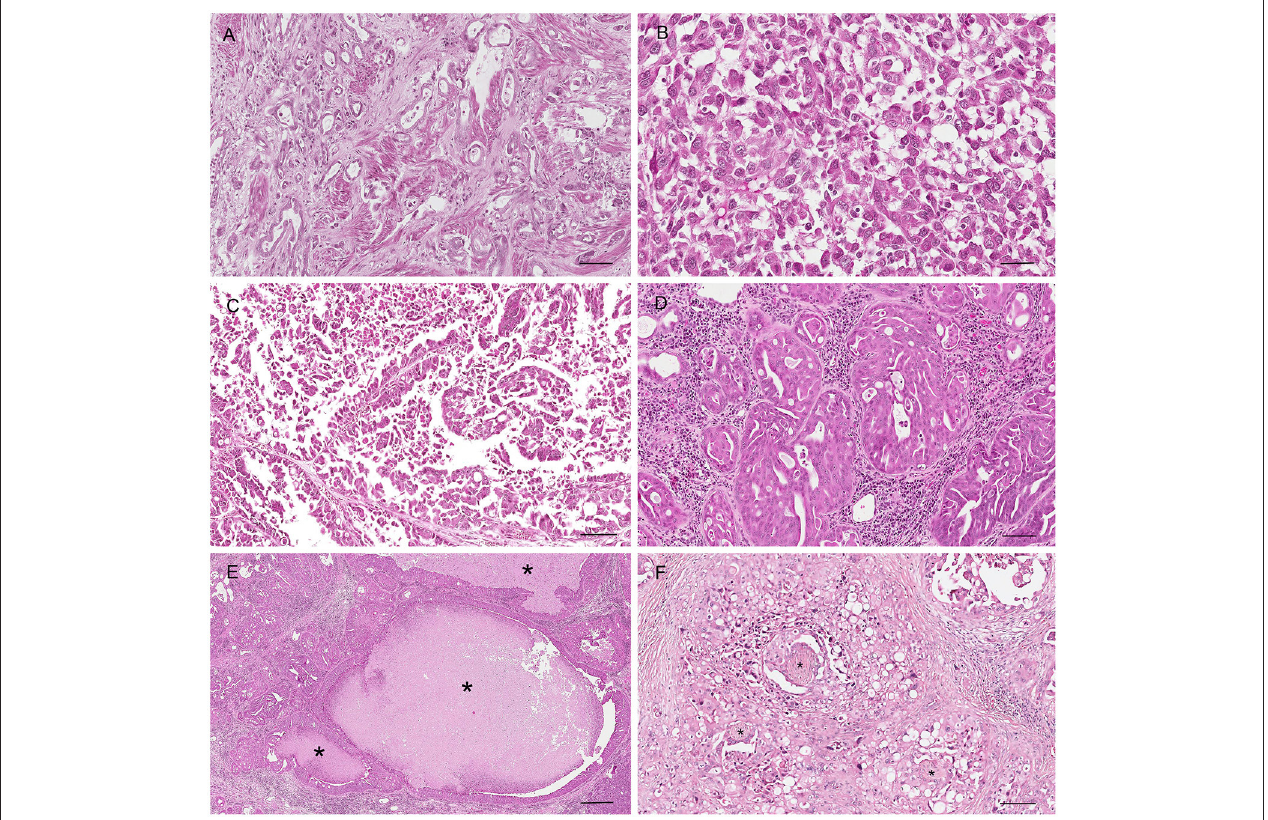
FIGURE 12 | Histological subtypes of canine prostatic carcinoma. (A) Tubular carcinoma: small tubules lined by neoplastic epithelial cells. Hematoxylin-eosin staining. Bar = 120 µ m. (B) Solid carcinoma: pleomorphic neoplastic cells arranged in sold nests without a glandular structure. Hematoxylin-eosin staining. Bar = 40 µ m. (C) Papillary carcinoma: neoplastic cells forming papillary projection within the lumen. Hematoxylin-eosin staining. Bar = 120 µ m. (D) Cribriform carcinoma: neoplastic cells filling the lumen with the formation of regular fenestrae. Bar = 120 µ m. (E) Cribriform carcinoma with central area of necrosis (comedonecrosis)